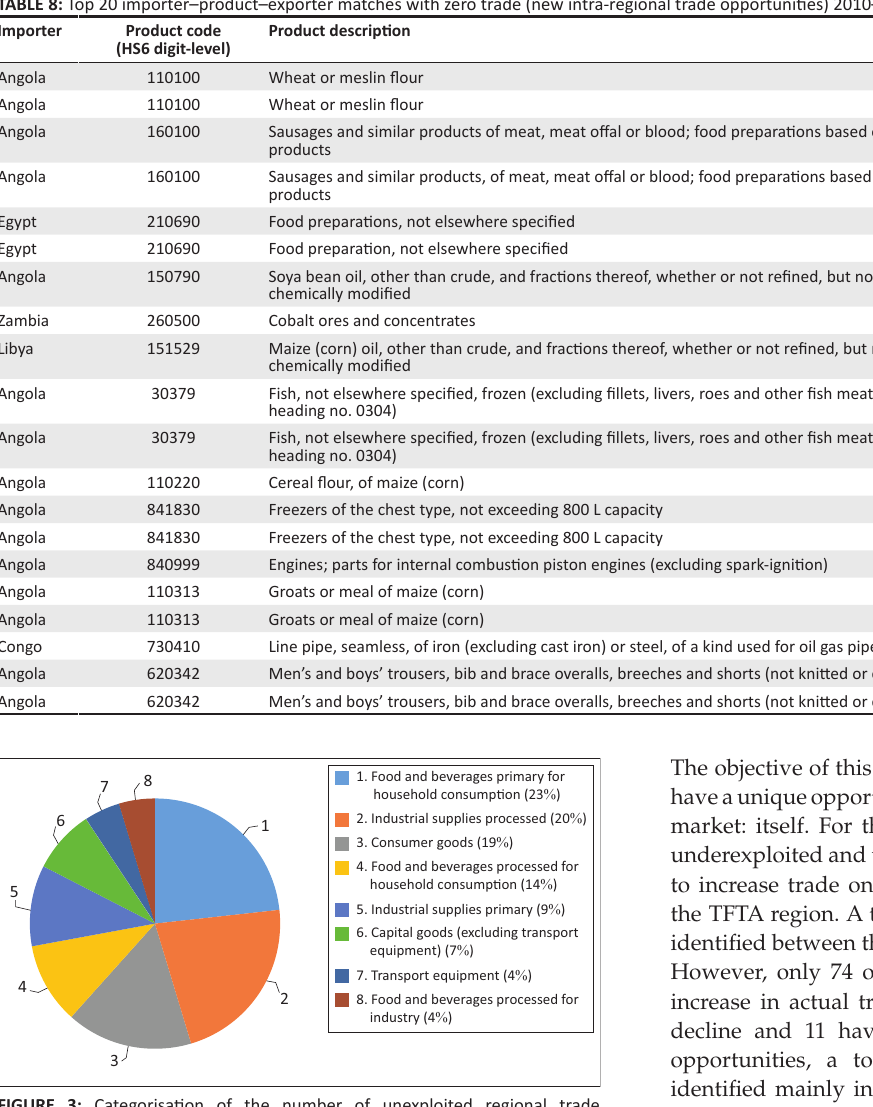
FIGURE 3: Categorisation of the number of unexploited regional trade opportunities: Percentage of unexploited trade by value.